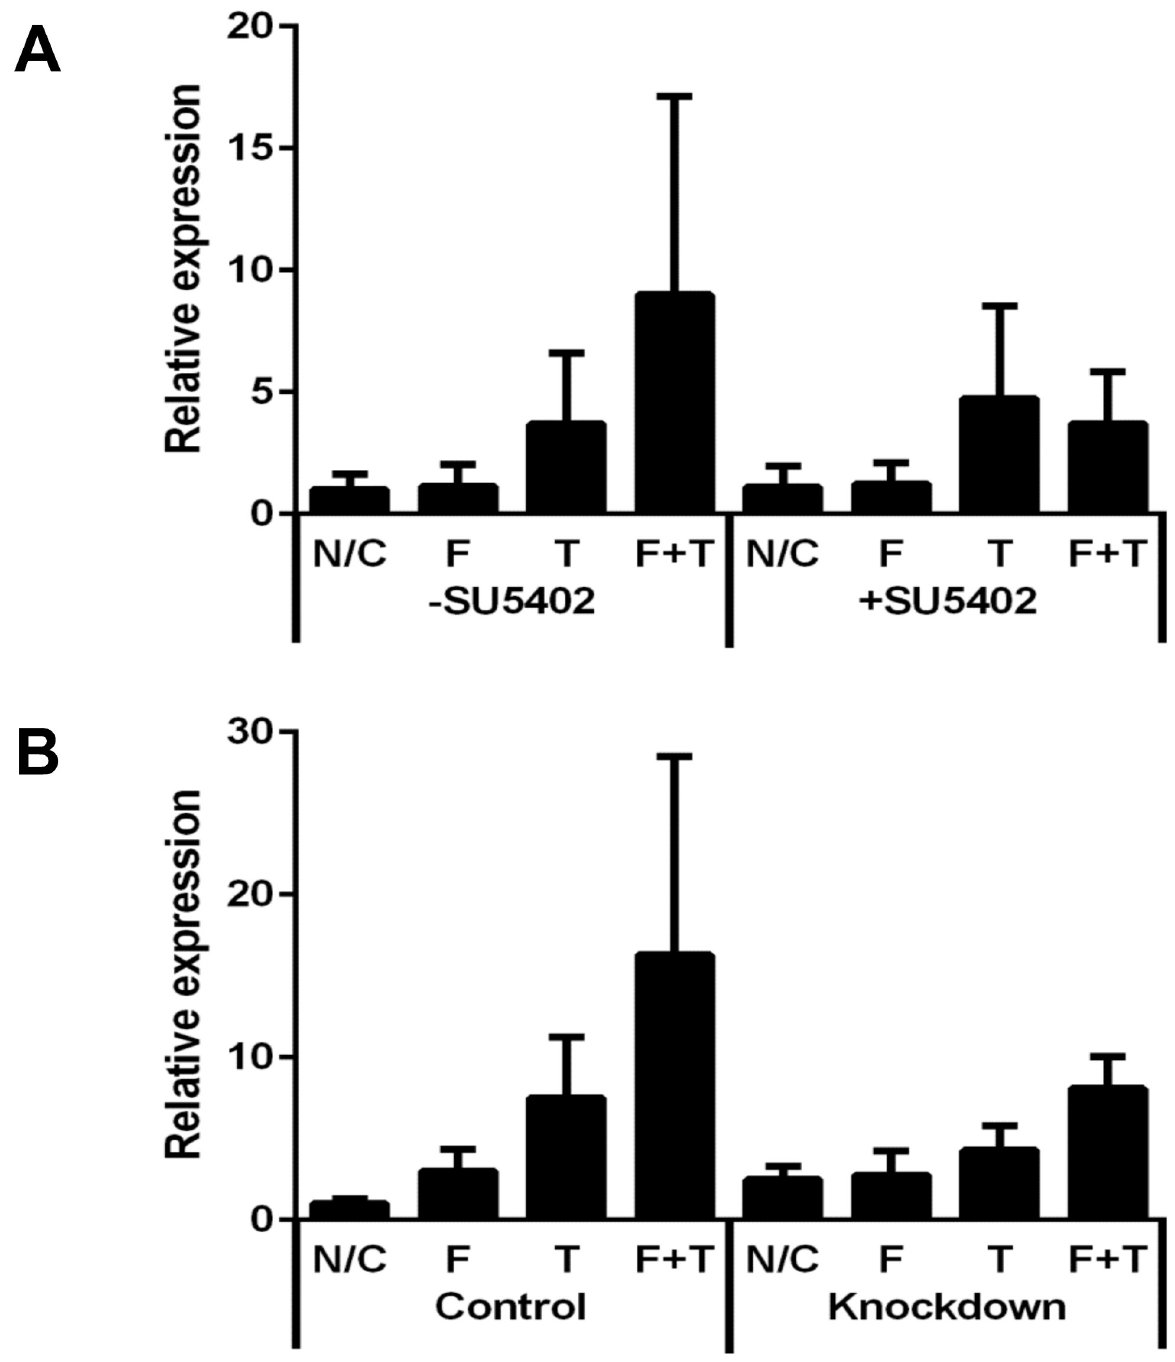
Fig 6. Relative α -SMA mRNA expression levels in fibroblasts after inhibition or down-regulation of FGFR1. Relative α -SMA mRNA expression levels in fibroblasts 3 days after treatment with FGF23 and/or TGF- β 1. (A) After treatment with FGFR1 inhibitor SU5402 (n = 5). (B) After down-regulation of FGFR1 (n = 4). N/C: Negative control; F: 25 ng/mL FGF23; T: 10 ng/mL TGF- β 1. Values are means ±